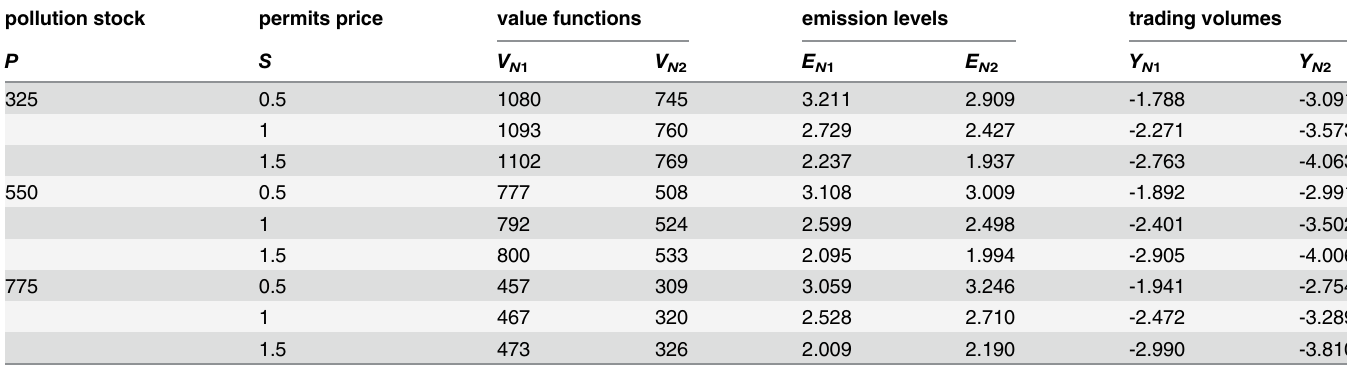
Table 1. The noncooperative game at t = 0.